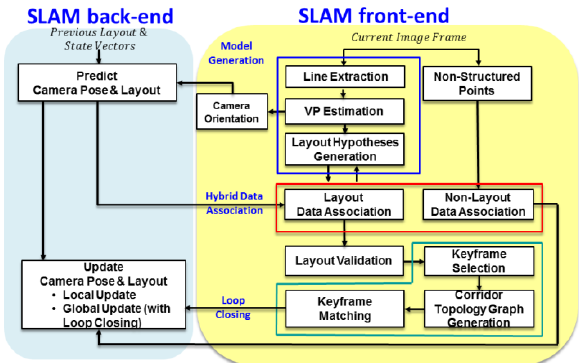
Figure 1. The pipeline of Layout SLAM with model-based loop